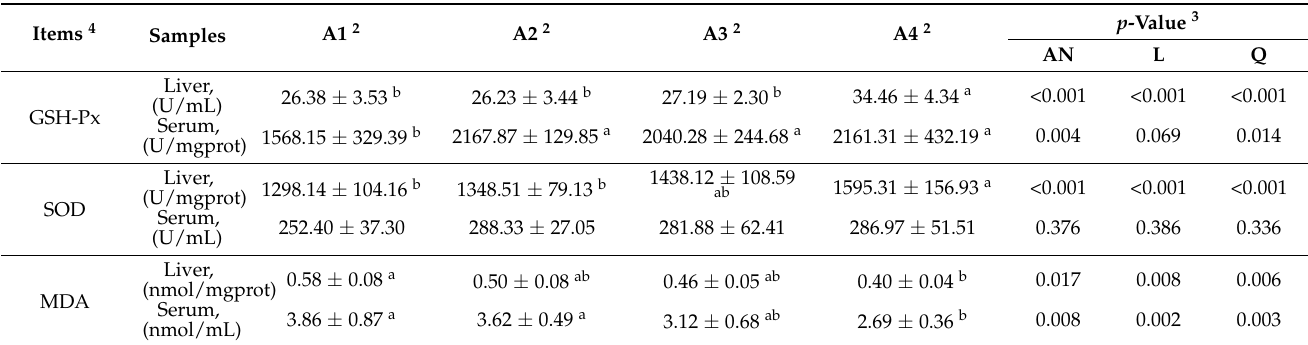
Table 6. Oxidation parameters of laying hens tested in liver and serum on week 12 (mean ± STD 1